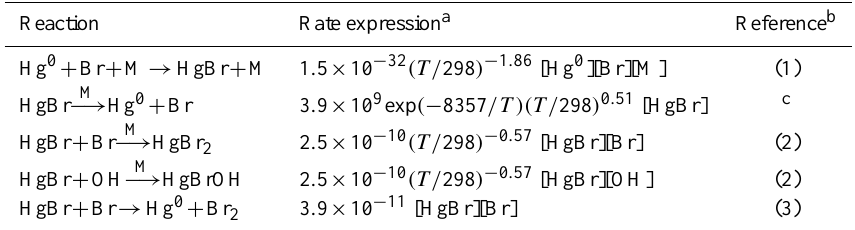
Table 1. Gas-phase mercury-bromine reactions in GEOS-Chem. Reaction Rate expression a